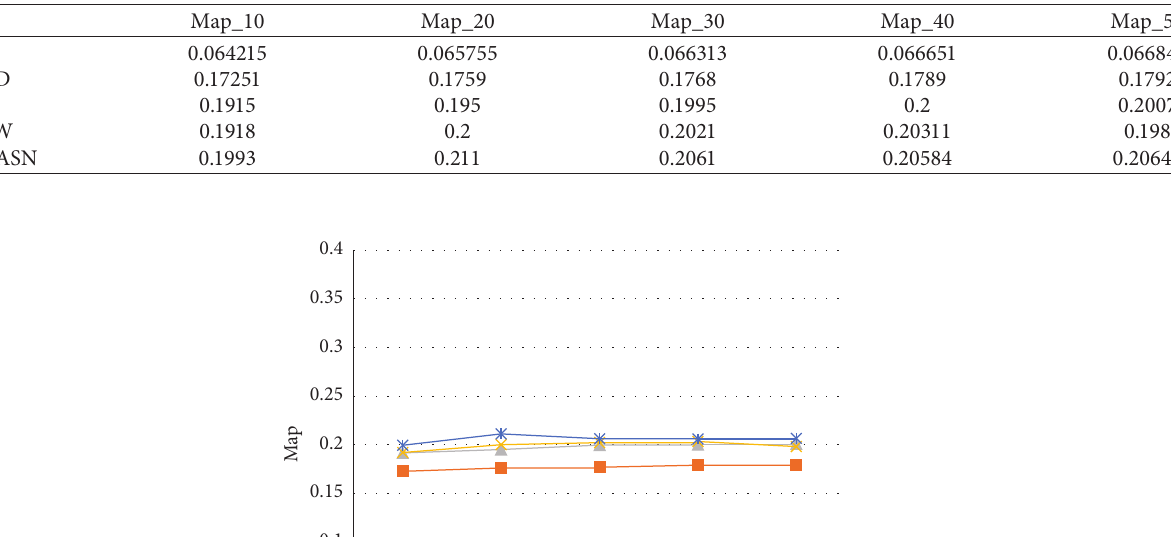
Figure 5: Comparison of F1 -Score values of various models. Table 5: Experimental results of Map.